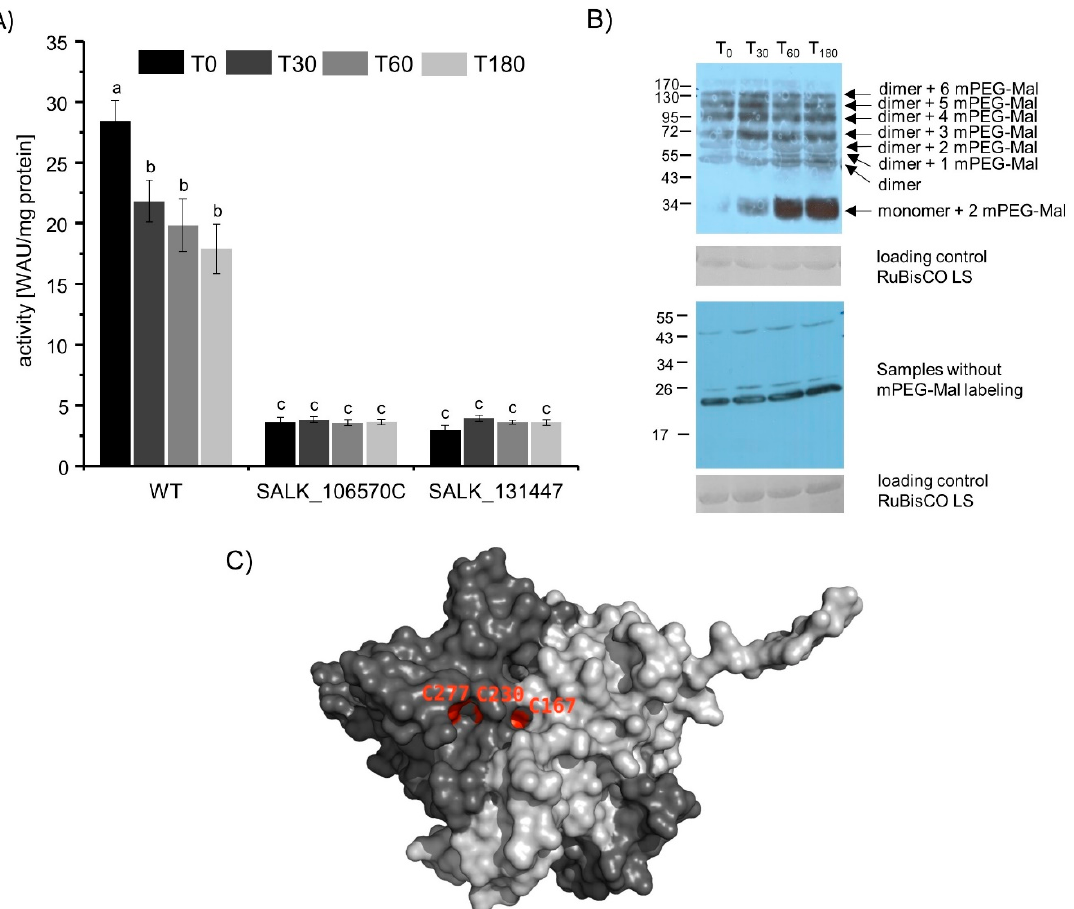
Figure 4. Effect of high light on CA activity and thiol redox state. Cut leaves were exposed to high light for 0, 30, 60, or 180 min. ( A ) Ex vivo -CA activity in whole leaf extract of WT, SALK_106570C, and SALK_131447 plants. The CA activity of the knock out lines of β CA1 ranged near 20% of WT CA activity. Data represent the mean of n ≥ 12 ± SE from three independent experiments. Significance of difference is indicated by letters a-c with p ≤ 0.05, calculated with one-way ANOVA and post hoc Tukey HSD test. ( B ) Western blot of the samples treated as in (A) with or without mPEG-Mal labeling and their corresponding loading control. Higher bands indicate additional labeling with mPEG-Mal due to addition of ~ 5kDa per accessible thiol in β CA1. ( C ) Accessible surface of β CA1 dimer (based on 1ekj). Only C167, C230, and C277 among the six Cys are accessible at the surface area of β CA1 and therefore, undergo alkylation via mPEG-Mal.